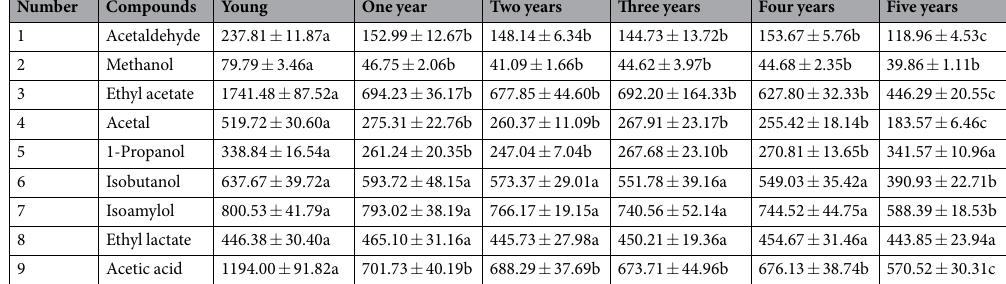
Table 1. Concentration of major volatile compounds in different aged Chinese liquors. All values are expressed as means (mg/L) ± standard deviation (SD). Different letters indicate significant differences (p <